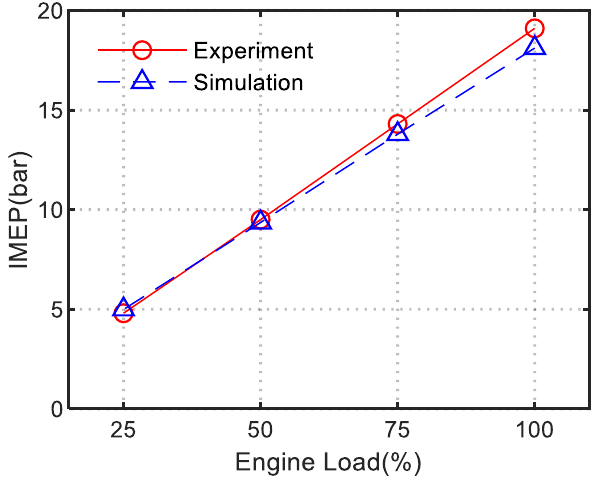
Figure 9. IMEP comparison between simulation and experiment.